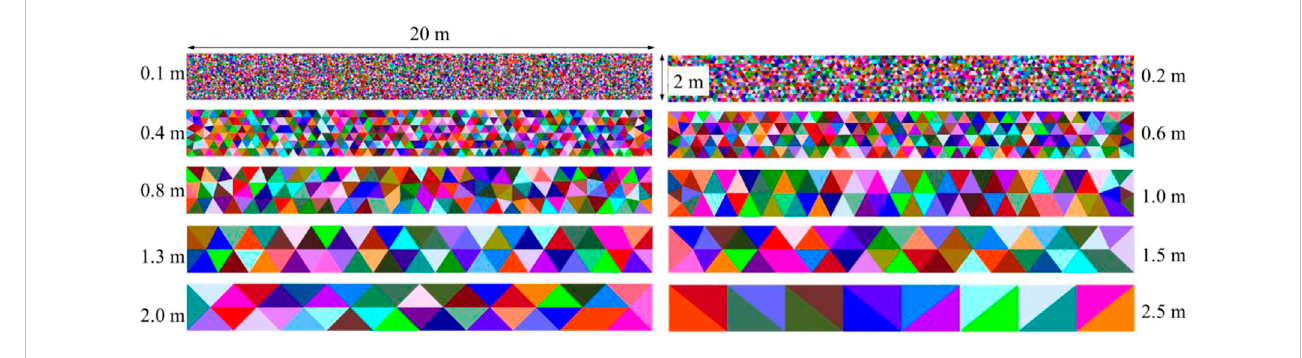
FIGURE 6 In fl uencing characteristics of the maximum edge length of the rigid block on the joints.